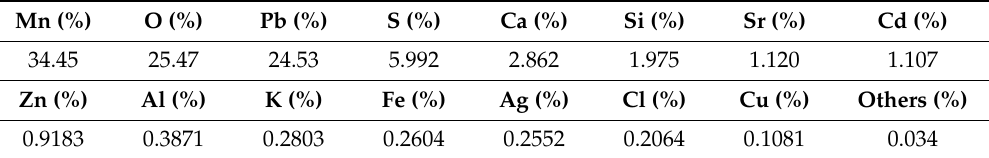
Table 1. Compositions of anodic lodes and scrapings from zinc electrolysis process. Determined by X-ray fluorescence (mass